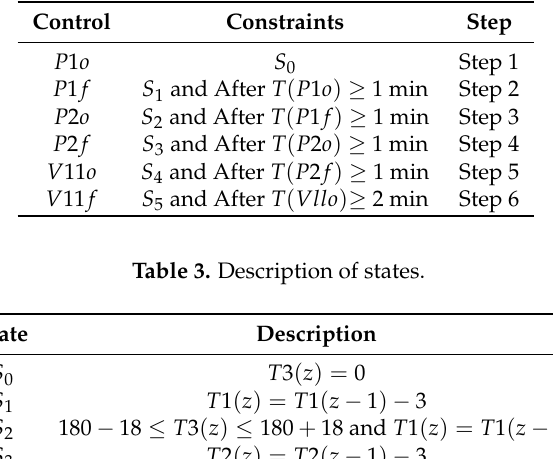
Table 2. Control Process where After T C i denotes the time that C i has been issued from the controller.